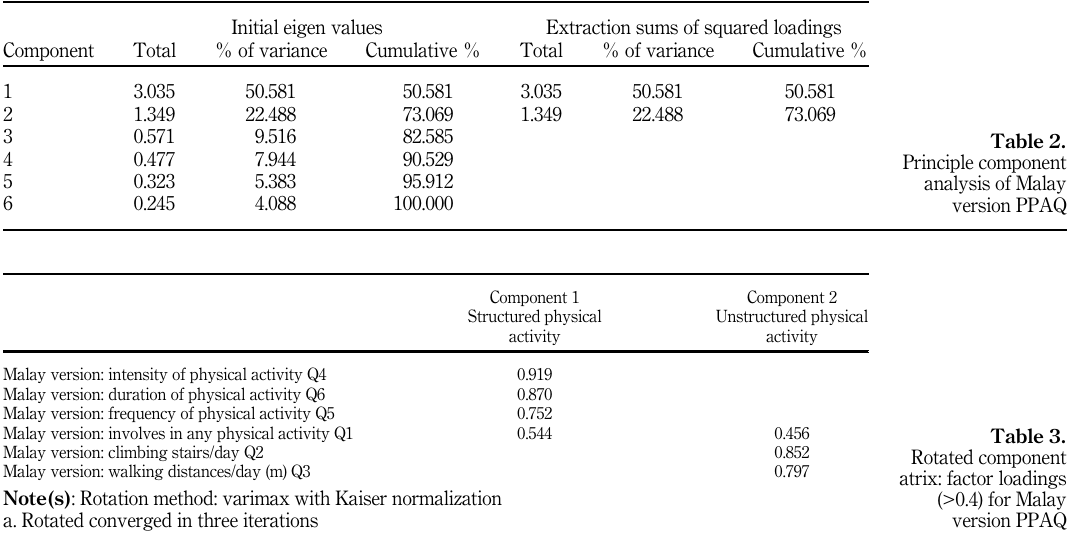
Table 3. Rotated